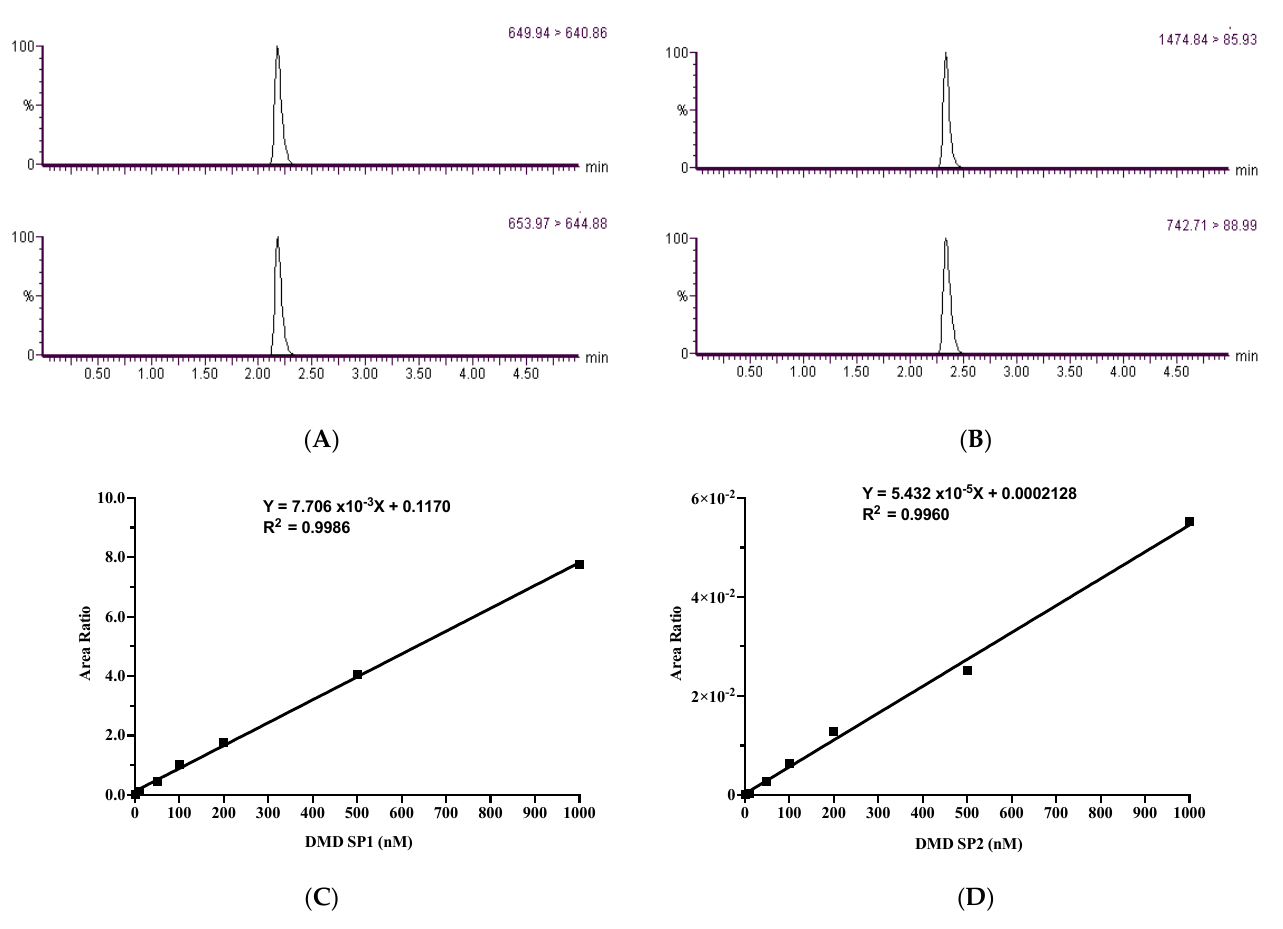
Figure 1. Representative extracted ion chromatography (EIC) and signature-peptide-based calibra- tion curves. ( A ) Extracted ion chromatograms for the dystrophin SP1 (649.94 > 640.86) (quantitative transition) and its labeled internal standard transition (653.97 > 644.88). ( B ) EIC of the quantitative transition for dystrophin SP2 (1474.84 > 85.93) and its internal standard (742.71 > 88.99). ( C ) Calibra- tion curve of the dystrophin SP1 and ( D ) dystrophin SP2.